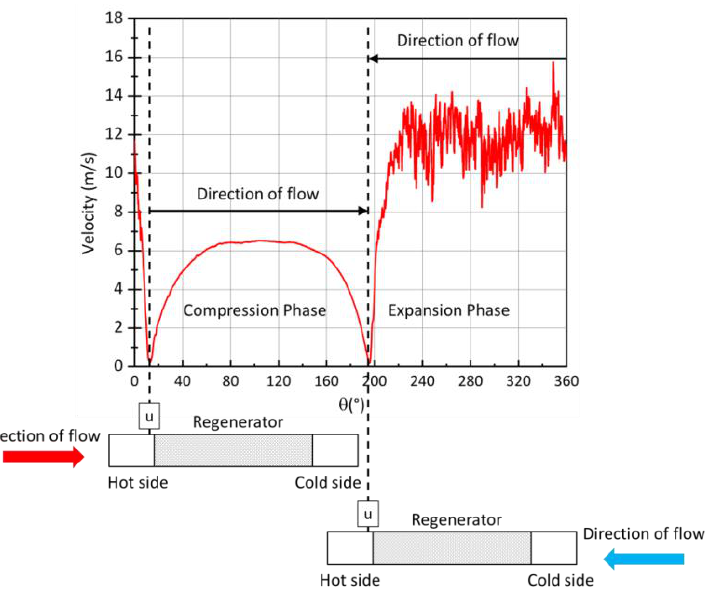
Figure 6. Evolution of the fluid velocity during the compression phase (or hot blow when the hot gas enters the regenerator) and expansion phase (or cold blow when the cold gas enters the regen- erator).